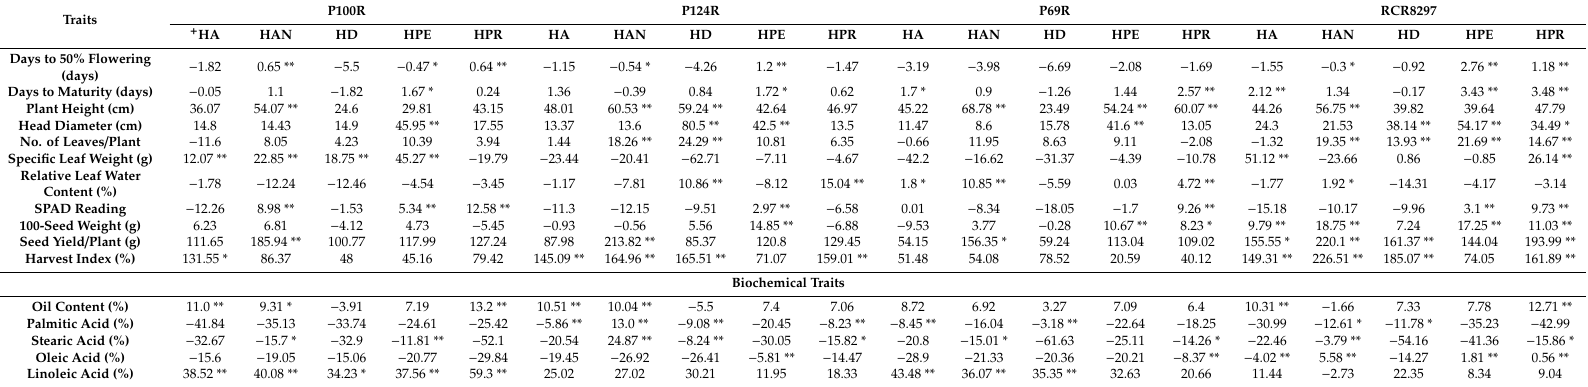
Table 3. Heterosis over mid-parent values (MPH, %) among CMS sources representing five di ff erent species of sunflower for morphophysiological, yield, and biochemical traits under normal irrigation.